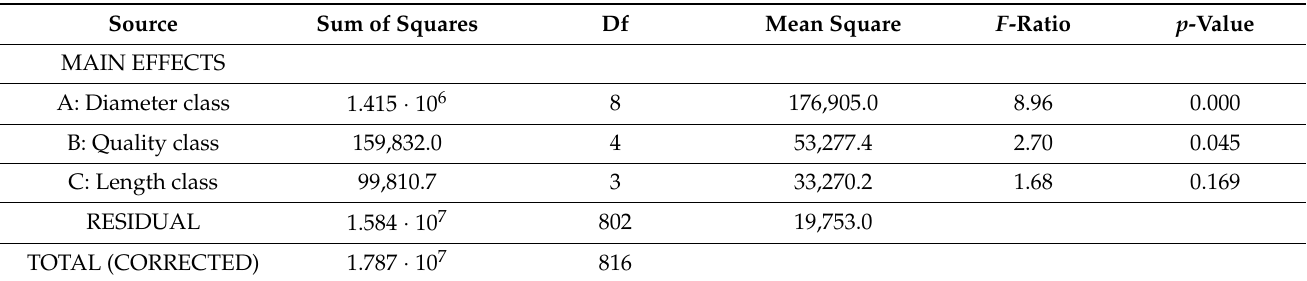
Table 3. Significance of the effect of diameter, quality, and length classes on the price obtained per cubic metre for the spruce logs at the auction (MANOVA, p < 0.05).